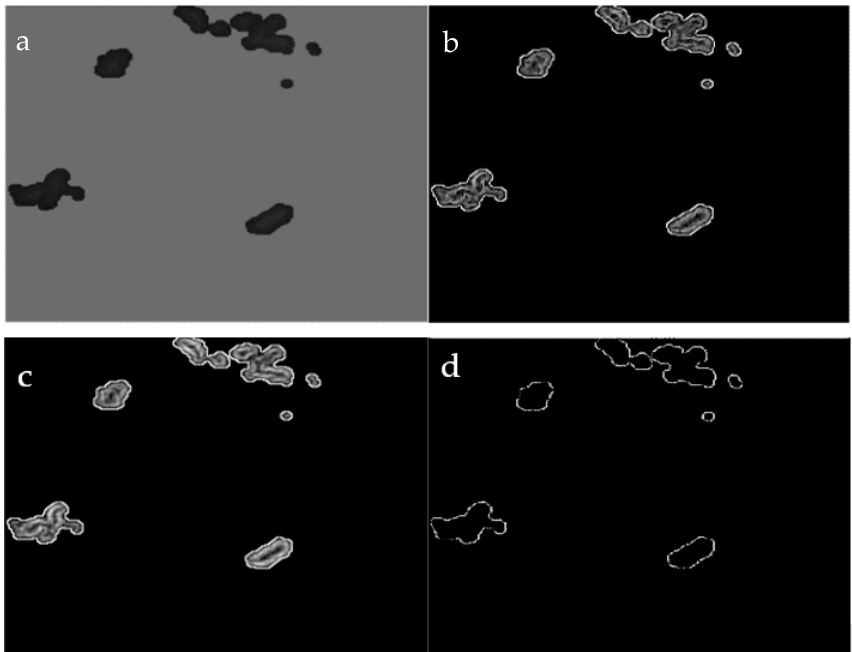
Figure 7. Expected exudates: hue channel ( a ), std_intensity ( b ), std_y ( c ), and entropy ( d ).